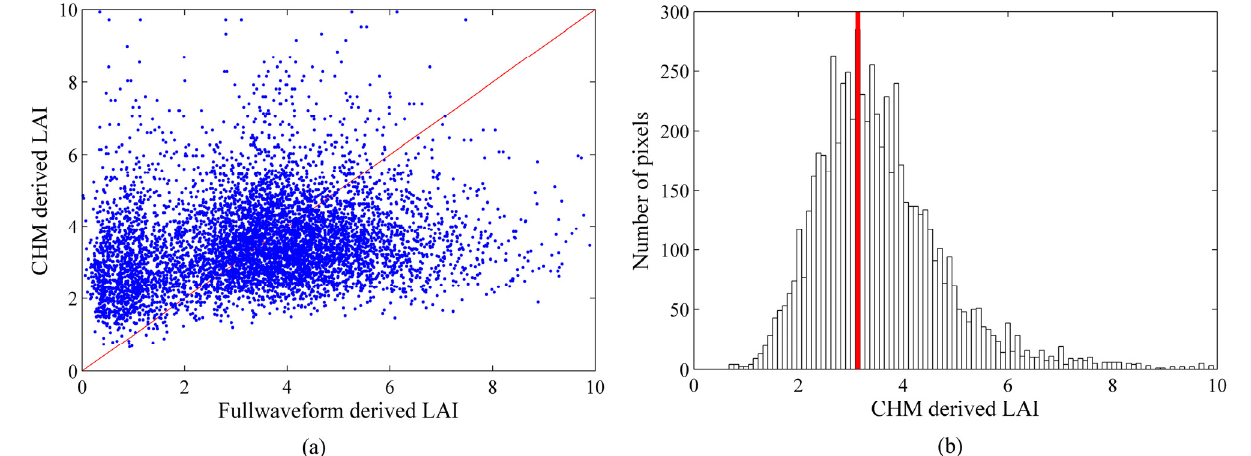
Figure 10. ( a ) Scatter plot of full-waveform derived LAI vs. CHM derived LAI (poor correlation, with r = 0.20); ( b ) Histogram of CHM derived LAI, with peak located at